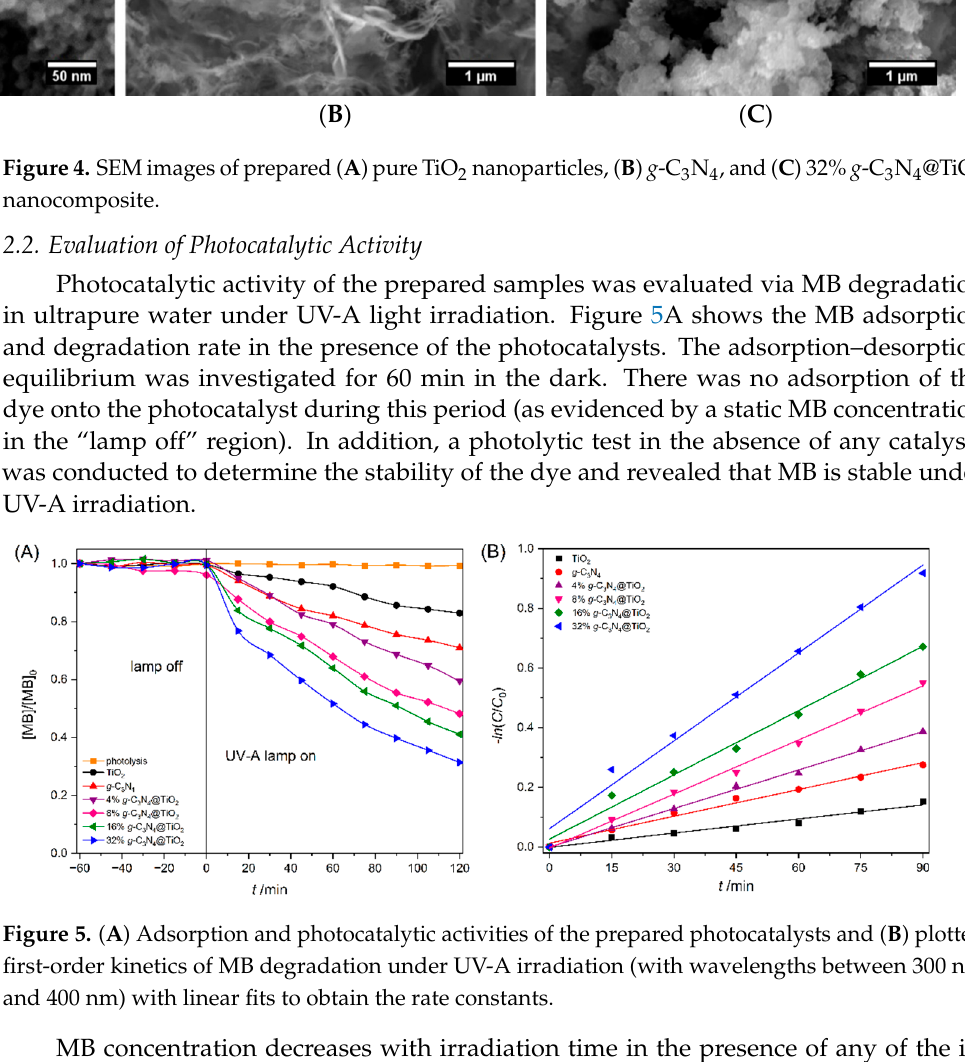
Figure 4. SEM images of prepared ( A ) pure TiO 2 nanoparticles, ( B ) g -C 3 N 4 , and ( C ) 32% g -C 3 N 4 @TiO 2 nanocomposite.